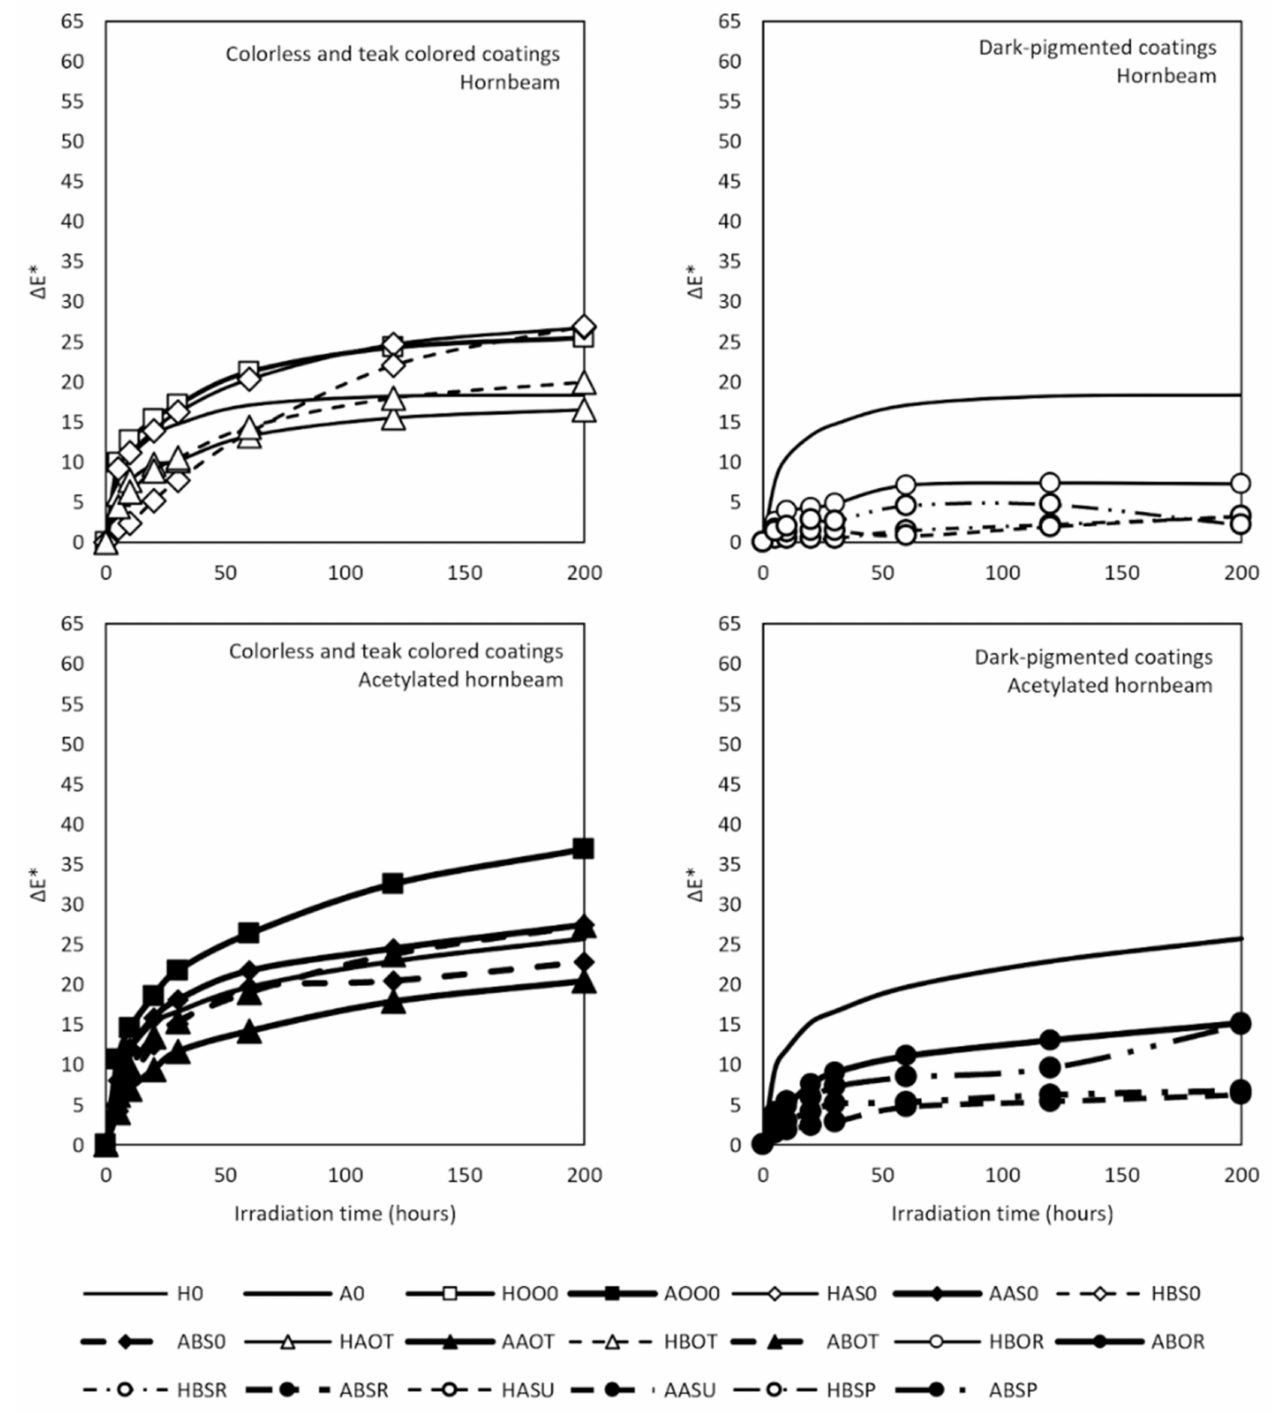
Figure 6. Change of color difference ( ∆ E*) during 200 h of xenon lamp